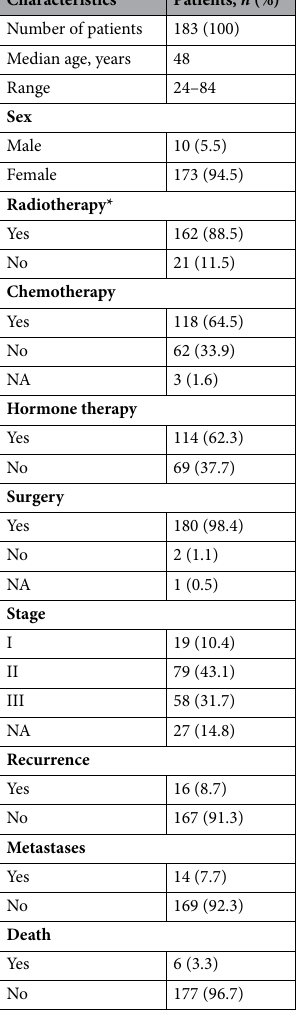
Table 1. Characteristics of breast cancer patients. Of the 183 BC patients, 180 underwent surgery, 162 were treated by radiotherapy (RT) (including 113 patients receiving both CT and RT, 46 treated by RT alone, and 3 for whom the presence or absence of CT was unknown), 118 received chemotherapy (CT) (including 113 receiving both CT and RT and five patients treated by CT alone), 114 patients received hormone therapy (including 28 treated by RT, 2 treated by CT, 77 treated by CT and RT, and 6 receiving only hormone therapy and have not been included in the 4 groups of BC patients presented in Fig. S3b). Ten patients received no treatment. *For 22 patients, the date of RT was not